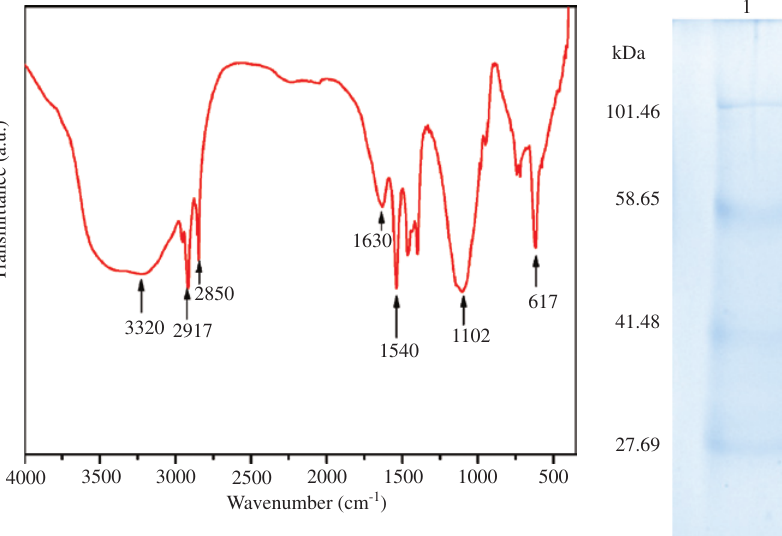
Figure 10: Fourier transform infrared (FTIR) spectrum of zinc sulfide nanoparticles synthesized using algal cell free extract.